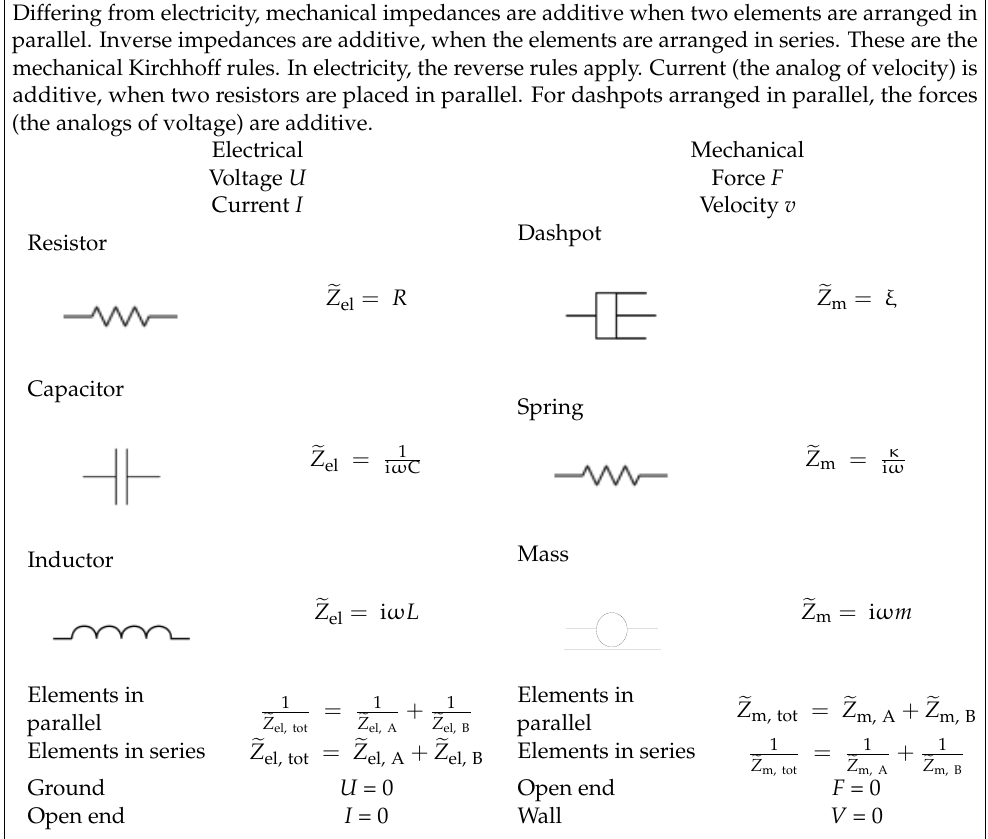
Figure 33. The frequency shift induced by a coupled resonance, following Equation (79). At low and high ω, the Sauerbrey limit and the elastic -load limit are recovered. The overtone scaling in these limits is − Δ f / n ≈ const and +Δ f · n ≈ const. In a range next to the Sauerbrey regime, the softness of the contact can be inferred from a non- trivial the overtone dependence of Δ f / n + iΔΓ/ n . Box 3 . The electromechanical analogy.